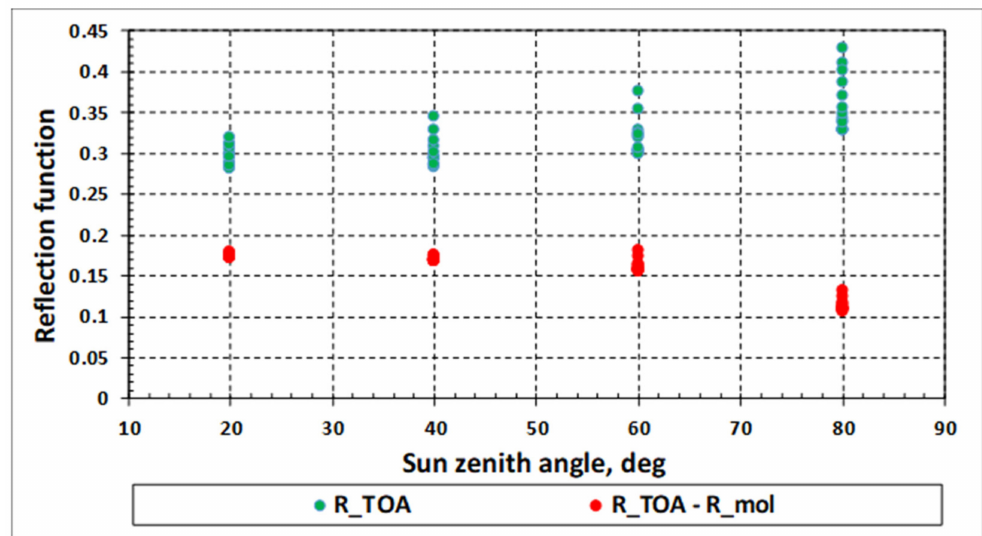
Figure 1. R TOA ( 412 nm ) and the difference R TOA ( 412 nm ) − R mol ( 412 nm ) under different observation conditions: solar zenith angles from 20 to 80 degrees, viewing angles 0, 15 and 30 degrees, azimuths of observation 45, 90, 135 and 180 degrees. Earth’s surface is